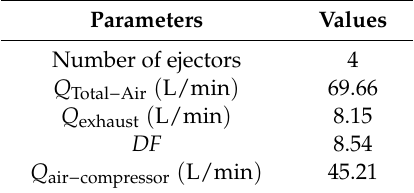
Table 4. Dilution factor and flow rate of the second layout.